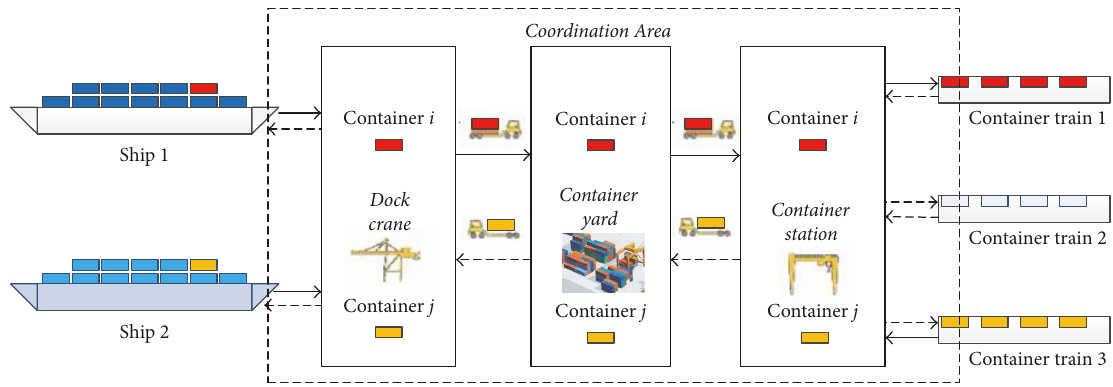
Figure 1: Coordination area of distribution organization in rail-yard-water mode